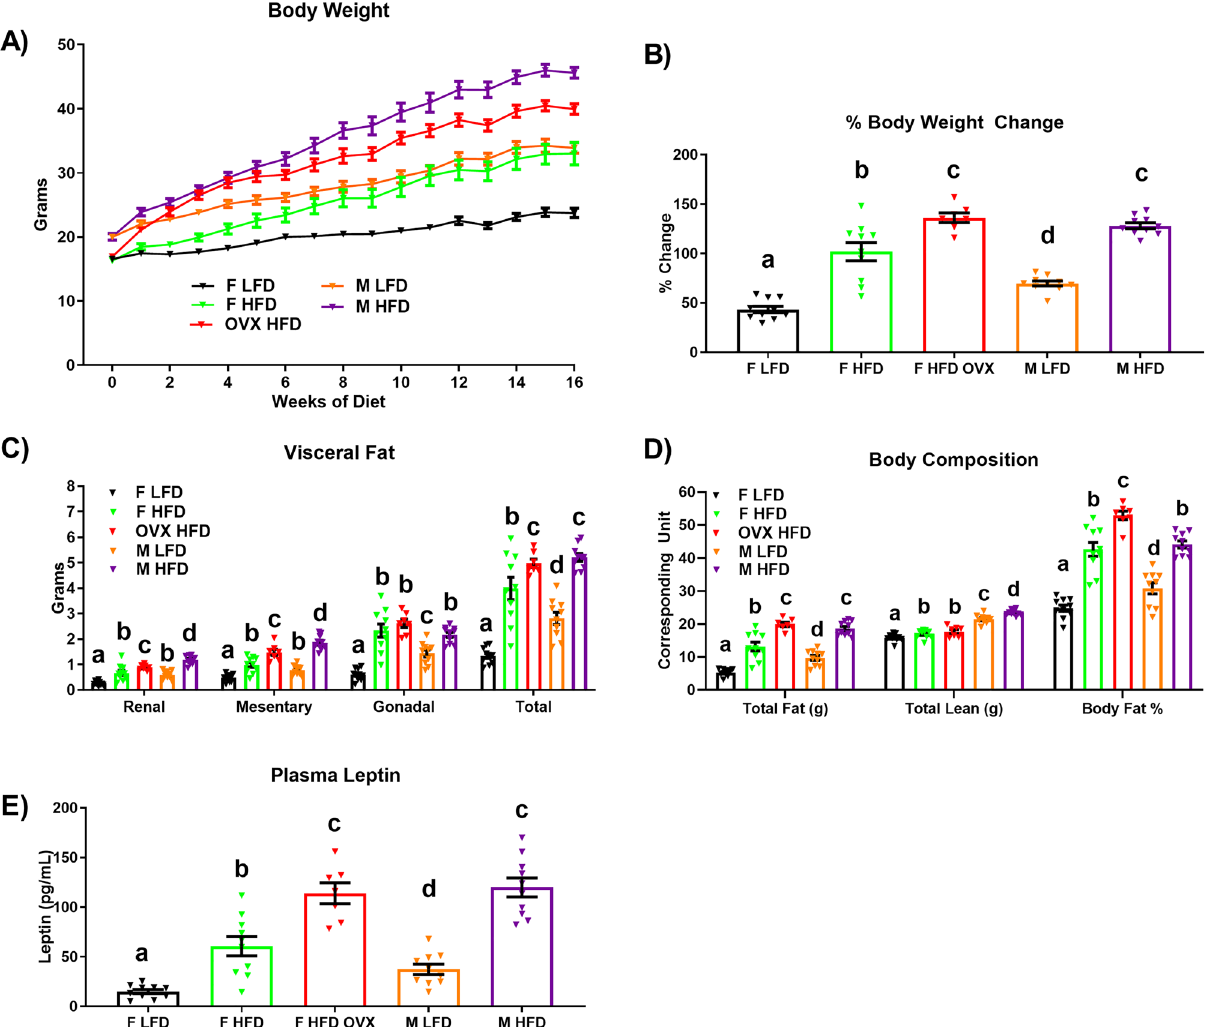
Figure 1. Female estrogen deficiency leads to a similar degree of adiposity as males in the setting of a high- fat diet (HFD). Male and female mice were fed a low-fat diet (LFD) or HFD for 16 weeks (n = 10/group). An additional group of HFD OVX mice (n = 7) were included in the study. ( A ) Body weight over the course of the study, ( B ) % change in body weight from baseline, ( C ) visceral fat accumulation, ( D ) body composition, and ( E ) plasma leptin levels. Data is presented as mean ± SE. Bar graphs not sharing a common letter are significantly different from one another (P <